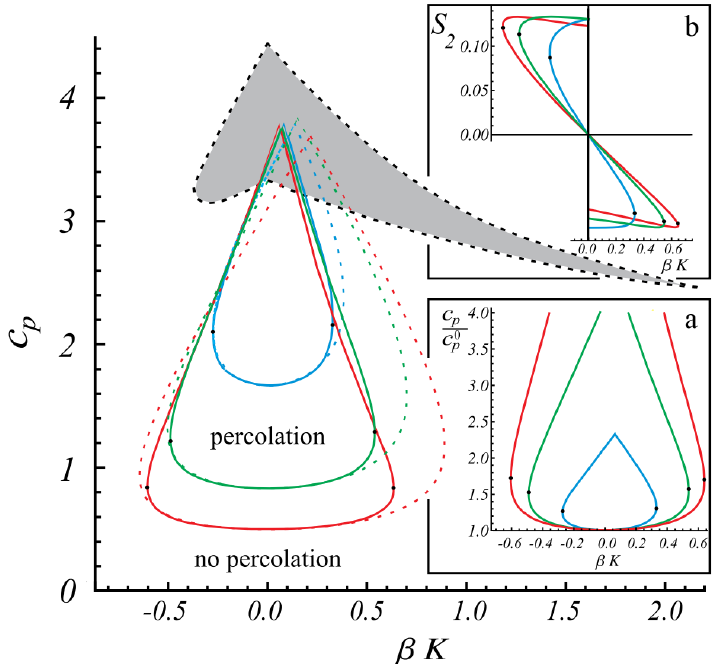
Figure 10. Scaled particle concentration c p = π DL 2 ρ p /4 at the percolation threshold as a function of the dimensionless field strength, β K . Where D refers to the diameter (particles were presumed mutually impenetrable rigid cylinders), L refers to the length and ρ p is percolation threshold). Solid lines— connectivity percolation; dashed curves—contact-volume approach for λ /D = 0.3 (top), 0.6 (middle) and 1 (bottom). The percolating network only existed in the enclosed areas. The shaded area is the region of coexisting isotropic (paranematic) and nematic phases. Inset ( a ): calculated percolation thresholds scaled to the zero-field value c 0p . Inset ( b ): order parameter S 2 with, from steepest to flattest, λ /D = 0.3, 0.6 and 1. The dots indicate the largest value of | β K| that allows for a percolation threshold [38].